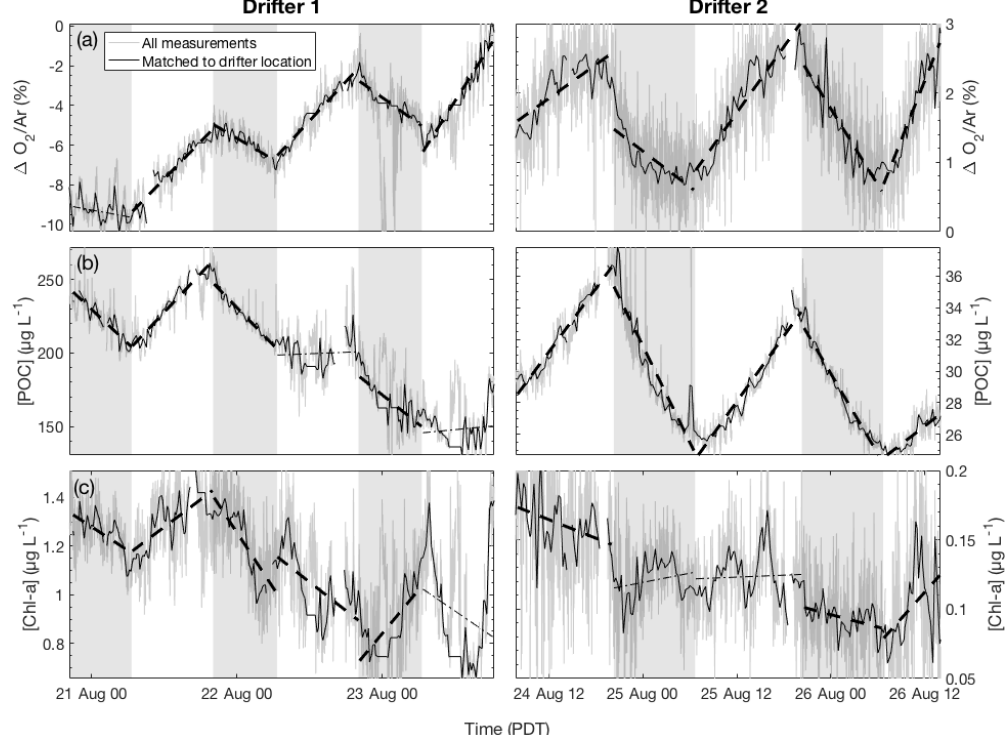
Figure 3. Time series of (a) biological oxygen saturation ( (cid:49) O 2 / Ar), (b) particulate organic carbon (POC) concentration, and (c) chlorophyll- a (Chl- a ) concentration during the two drifter deployments (left and right panels, respectively). For each daytime (nonshaded) and nighttime (shaded) interval, the best-fit linear regression line is plotted. Significant regressions ( p < 0 . 05) are plotted as thick dashed lines, while nonsignificant regressions ( p ≥ 0 . 05) are plotted as thin dotted lines. Gray lines show all measurements while thicker black line shows observations collected when the ship was within 1.5km of the drifter